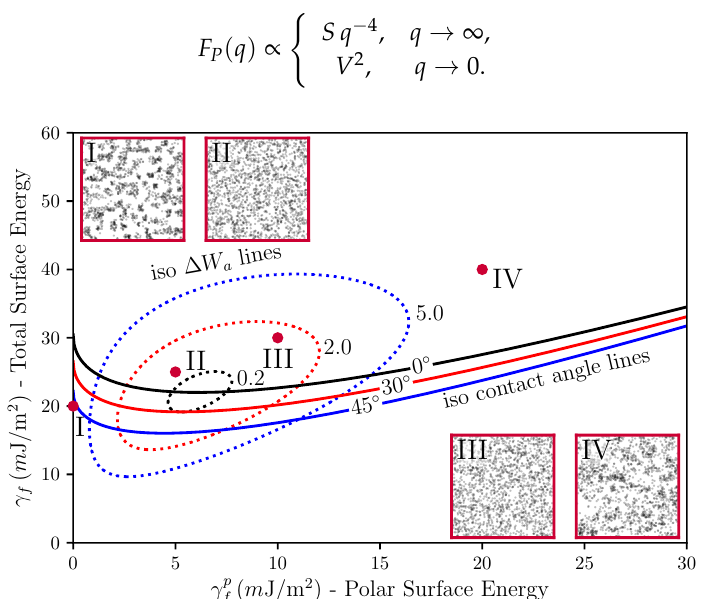
Figure 5. Plot of the polar part of the surface energy versus the total surface energy of the filler particles with constant wetting angles (solid lines), iso- ∆ W a lines (dotted loops), in units of mJ/m 2 , and TEM = 20 mJ/m 2 . Systems I to IV pictures. The dispersive part of the filler particles was kept fixed at γ d f only differ in their γ p -values. The polymer is natural rubber (NR, TMR—Standard Malaysian Rubber f SMR 20, γ d p = 15.9 mJ/m 2 and γ p p = 6.1 mJ/m 2 ). Filler volume content is φ = 15% and temperature is T = 140 ◦